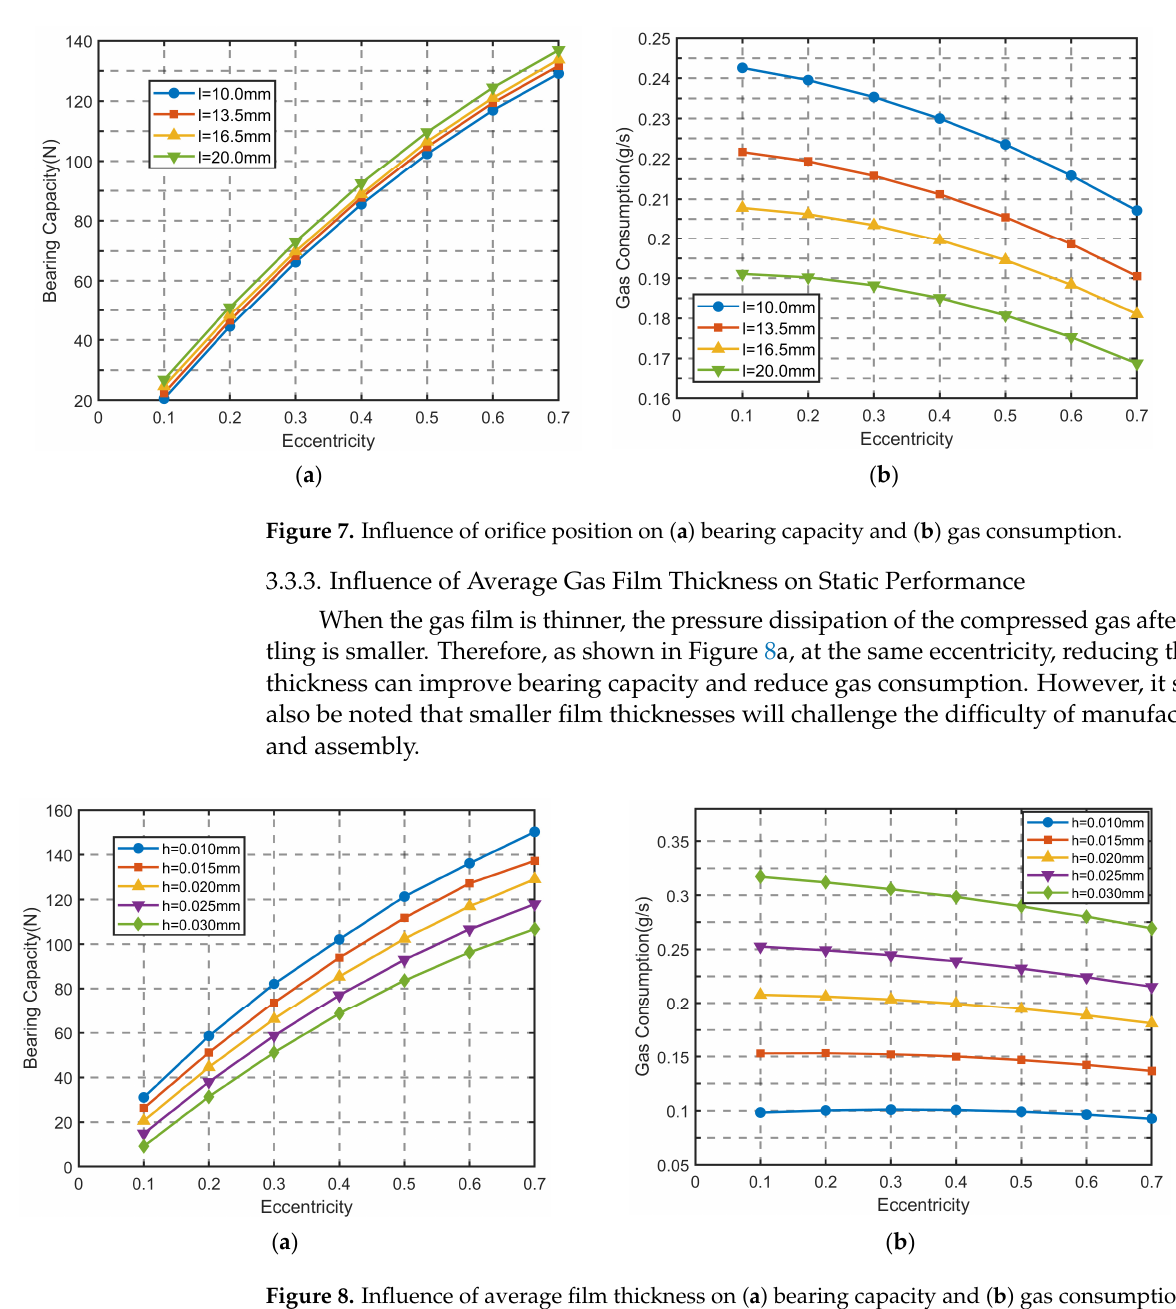
( b ) Figure 6. Influence of orifice diameter on ( a ) bearing capacity and ( b ) gas consumption.